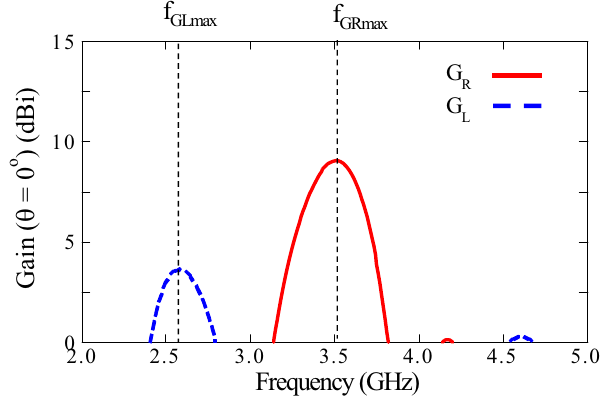
Fig. 4. Frequency response of the gain.